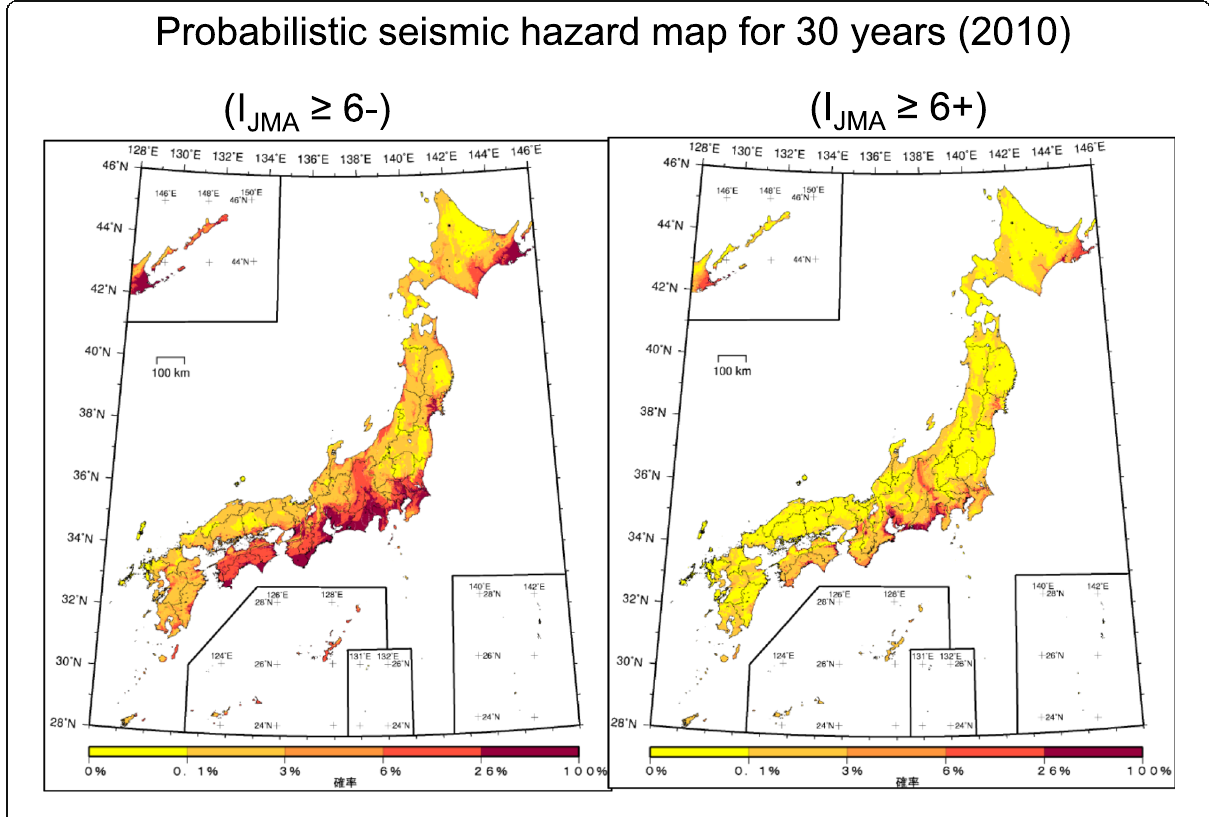
Fig. 7 Probabilistic hazard map of ground motion for 30 years published in 2010. The original figures were downloaded from the website of the Headquarters for Earthquake Research Promotion: (https://www.jishin.go.jp/evaluation/seismic_hazard_map/shm_report/shm_report_2010/. https:// www.jishin.go.jp/main/chousa/10_yosokuchizu/ka_bunpu.pdf). This site is in Japanese only; a corresponding site in English is https://www.jishin.go.jp/main/ index-e.html that shows only the 2007 version and is not updated. There are areas along the Pacific coasts from Kanto to Shikoku and northeastern Hokkaido where ground shaking of I JMA 6 − or greater was predicted to occur in the coming 30 years with a probability of more than 6% (left). Probabilities of 6% or higher for ground shaking of I JMA 6+ or greater were predicted only for narrow zones along the Itoigawa-Shizuoka Tectonic Line and the coast in Tonankai region, and for other small areas (right). Note that these hazard maps show low probabilities of less than 6% to most of the regions which were struck by strong ground shaking of I JMA 6 − and greater during the 2011 Tohoku-Oki and the 2016 Kumamoto